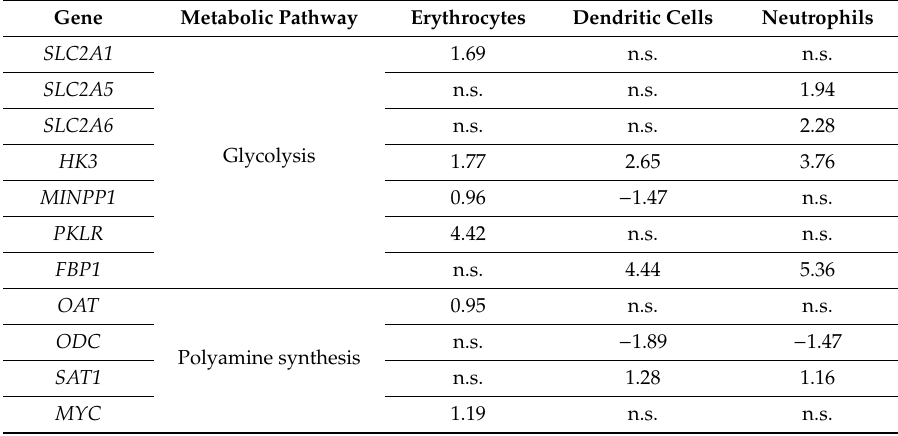
Table 2. Transcriptional changes in pathway-related genes in each population. Given is gene name, the corresponding metabolic pathway and the log 2 fold change, compared to the progenitor population. Changes with a corresponding p value > 0.05 were considered not significant (n.s.).